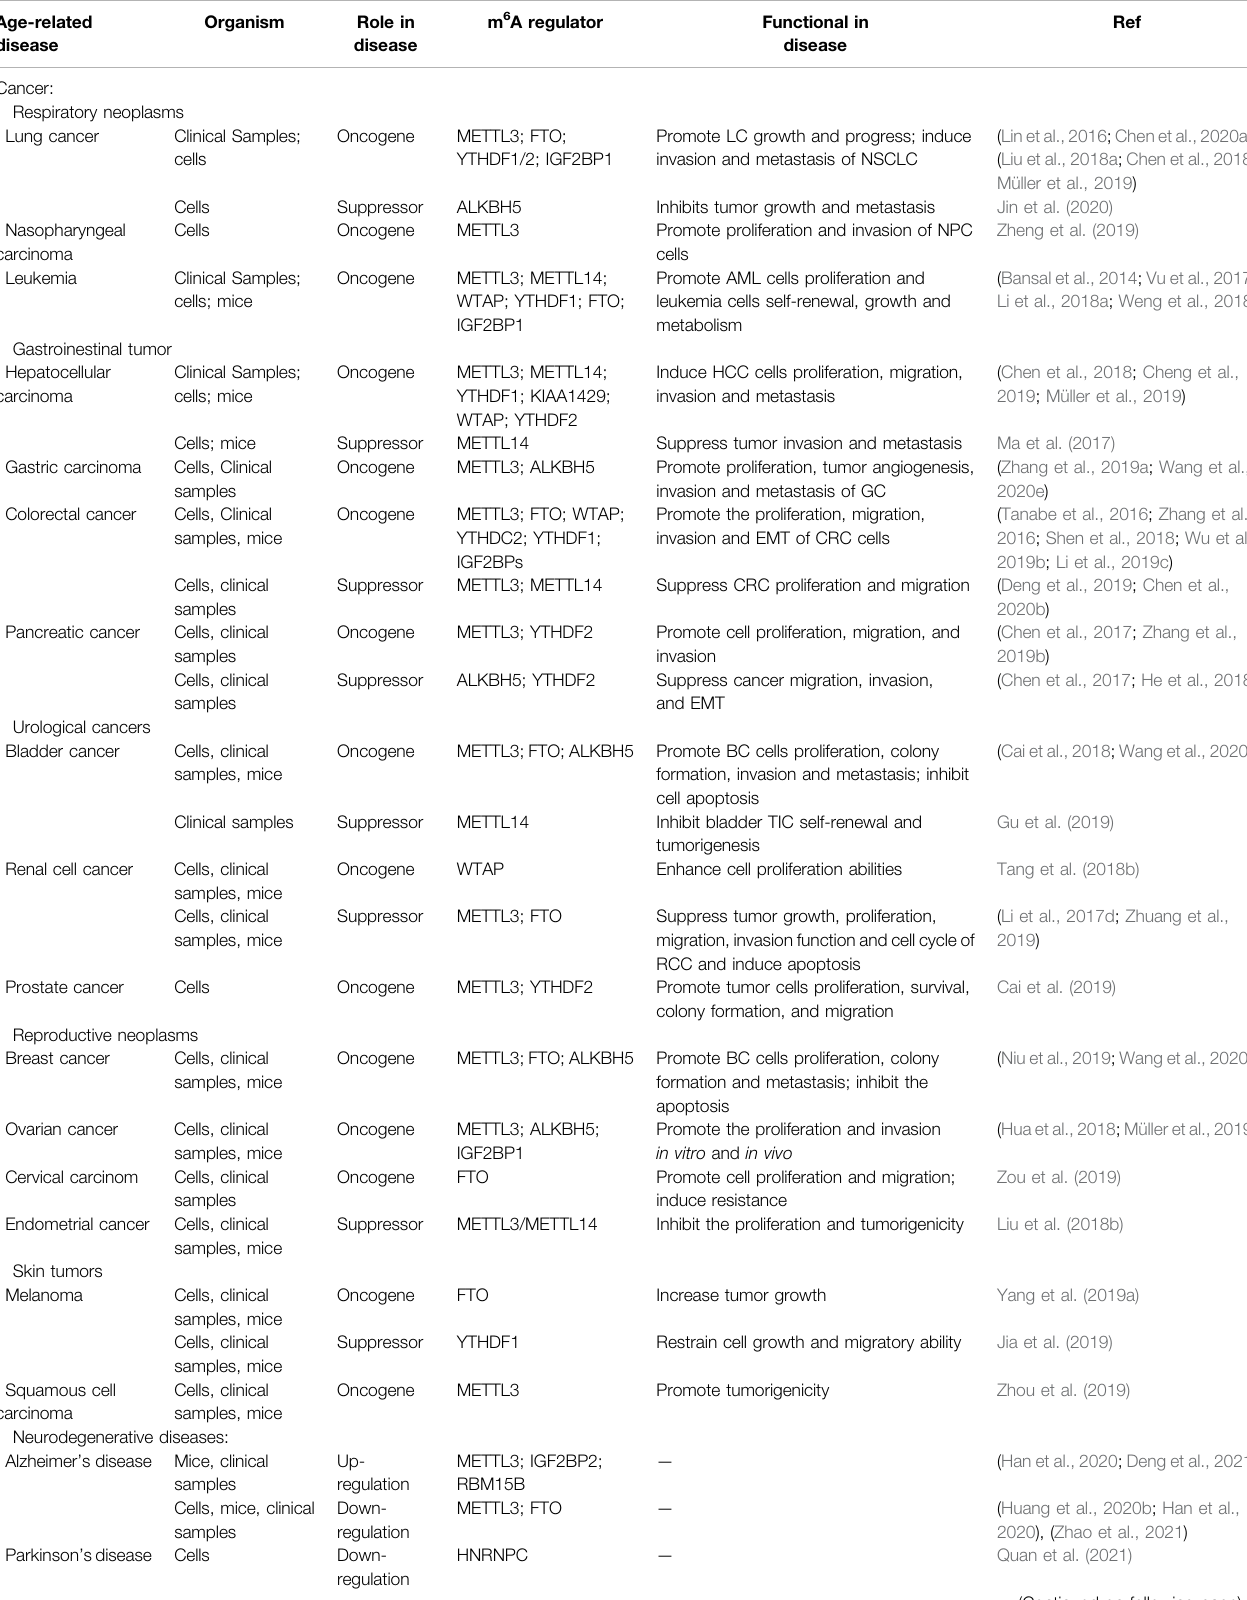
TABLE 2 | The functional roles of RNA m 6 A modi fi cation in various types of human